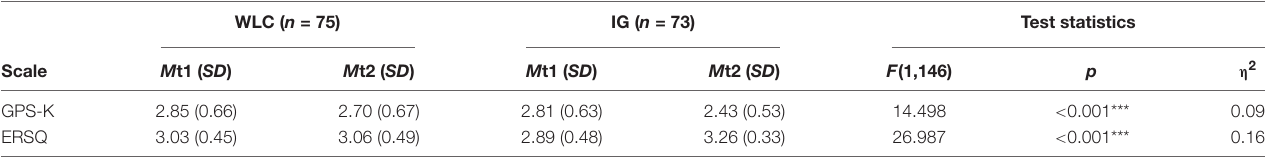
TABLE 1 | Means, standard deviations, and test statistics of the procrastination scores (GPS-K) and ER skills scores (ERSQ) for the intervention (IG) and the wait-list control group (WLC). WLC ( n = 75) IG ( n = 73)